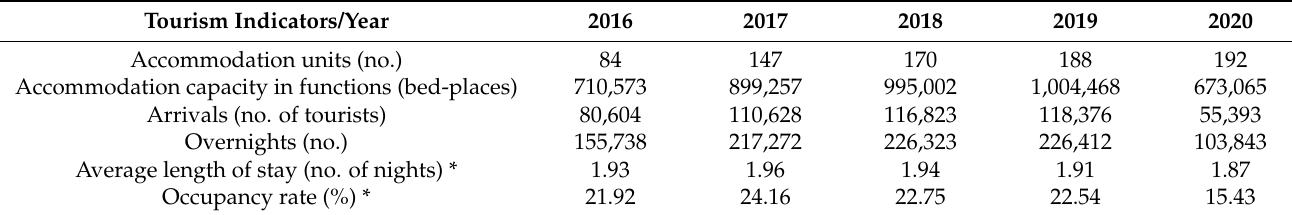
Table 1. Time evolution of tourism indicators in rural areas of Cluj